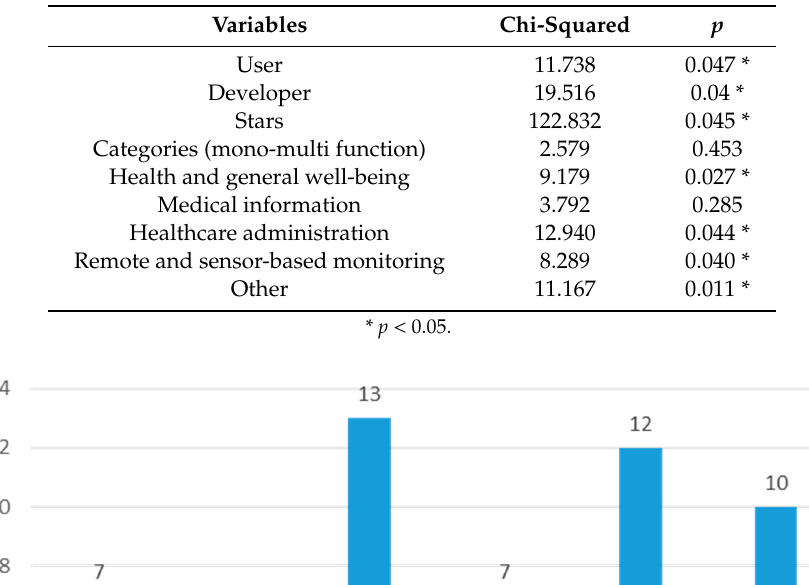
Table 3. Chi-square tests.